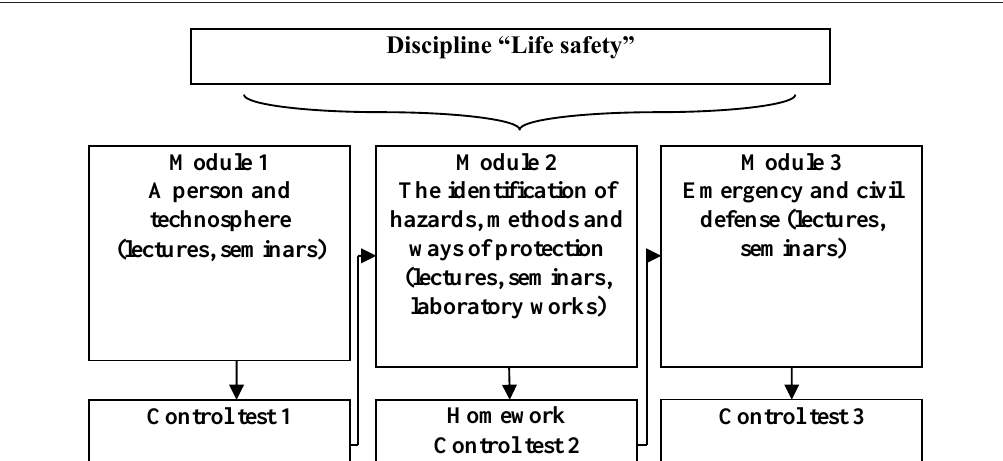
Fig. 1. The structure and contents of discipline «Life safety» in Bauman Moscow State Technical University.